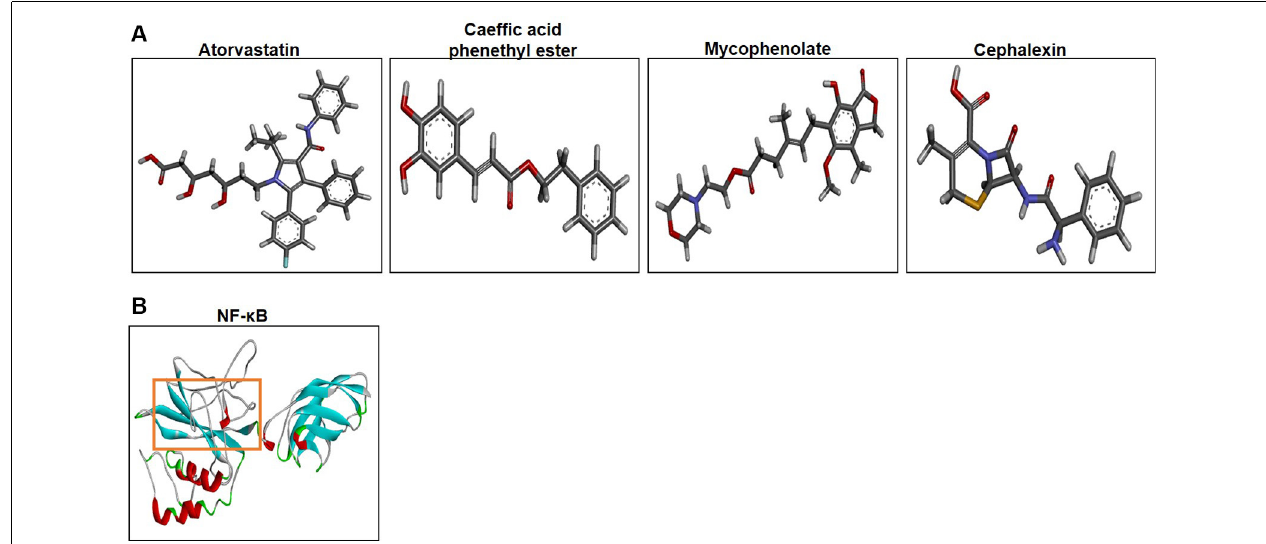
FIGURE 2 | 3D structures of atorvastatin, cephalexin, mycophenolate, caeffic acid phenethyl ester (CAPE), and the nuclear factor kappa beta (NF- κ B). (A) Atorvastatin, cephalexin, mycophenolate, and (CAPE) were retrieved from https://www.drugbank.ca/ and converted to PDB format. (B) The crystal structure of NF- κ B (PDB ID: ILE9/ILE5) was retrieved from RCSB. NF- κ B active pocket composed of (tyrosine 36, arginine-54, arginine-56, tyrosine-57, cysteine-59, glutamic acid-60, histidine-64, lysine-144, lysine-145, lysine-272, glutamine-274, and arginine-305) is shown by a red square.